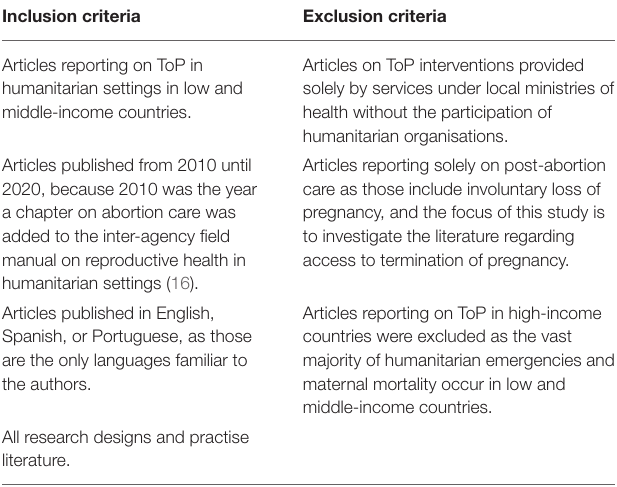
TABLE 1 | Eligibility